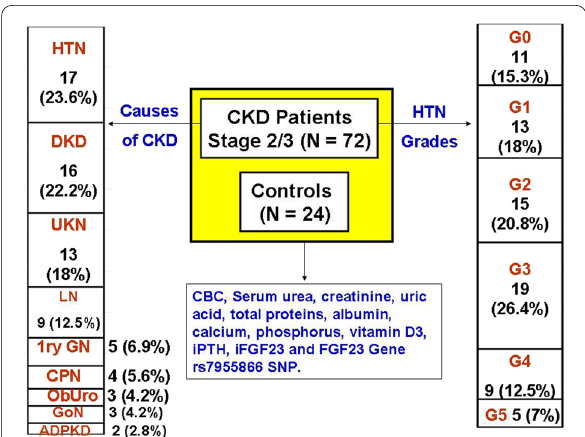
Fig. 1 Study flowchart. Main causes of CKD were hypertension (HTN), diabetic kidney disease (DKD), unknown cause (UKN), lupus nephritis (LN), primary glomerulonephritis (1ry GN), chronic pyelonephritis (CPN), obstructive uropathy (ObUro), gouty nephropathy (GoN), and autosomal dominant polycystic kidney disease (ADPKD).